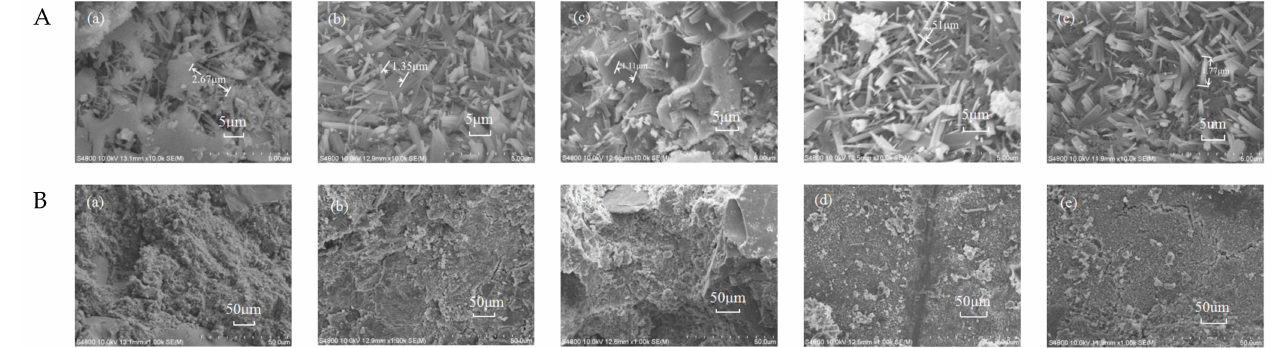
Figure 11. SEM image of grouting. ( A ): Grouting materials amplified to 5 µ m: ( a ) Undoped; ( b ) 1.2% NF; ( c ) 0.4% NA; ( d ) 1.2% NM; ( e ) 0.8% NS. ( B ): Grouting materials amplified to 50 µ m: ( a ) Undoped; ( b ) 1.2% NF; ( c ) 0.4% NA; ( d ) 1.2% NM; ( e ) 0.8%